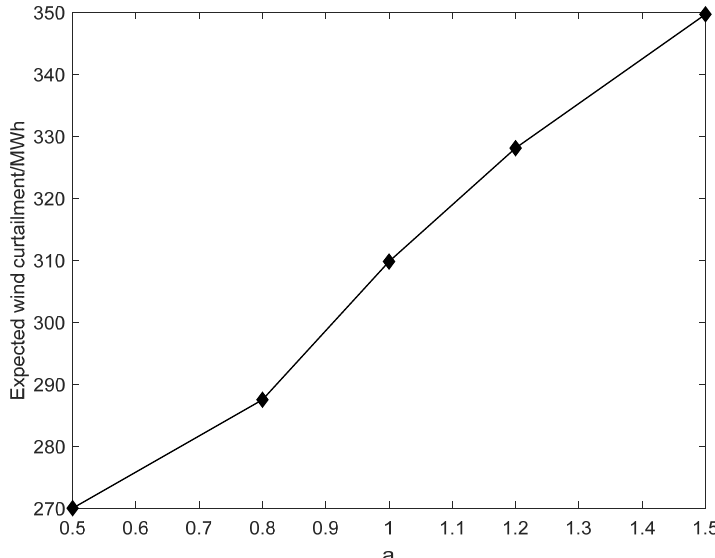
Figure 9. The expected wind power curtailment with different values of parameter a.